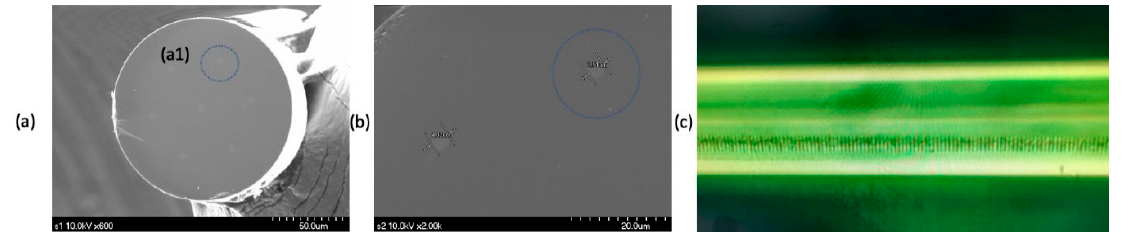
Figure 1. ( a ) cross-section photograph of the optical fiber used. ( b ) a cross-sectional picture of the diameter of the core. ( c ) electron microscope observation photo of the side of the core processed by femtosecond laser grating.